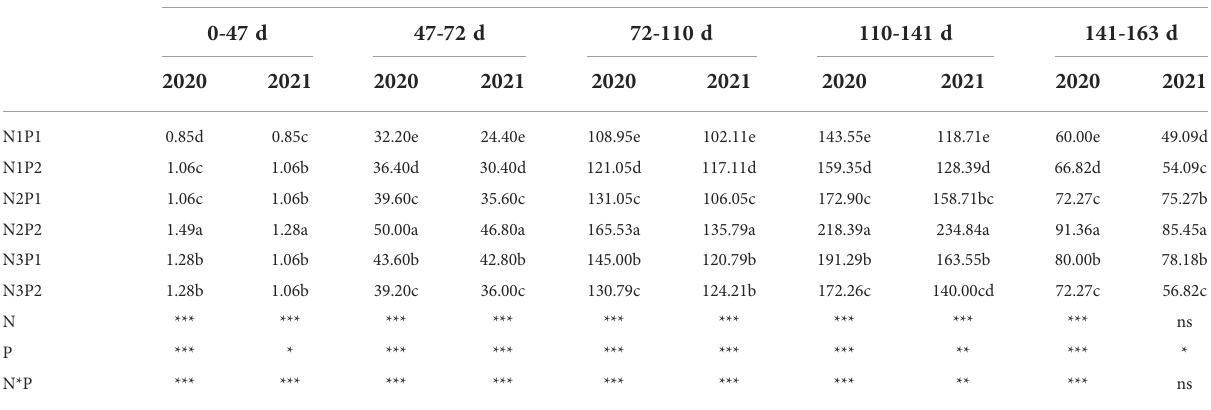
TABLE 4 Effects of different nitrogen and phosphorus combinations on relative growth rate (RGR) of sesbania pea at different growth stages in saline soil in 2020 and 2021. Treatment